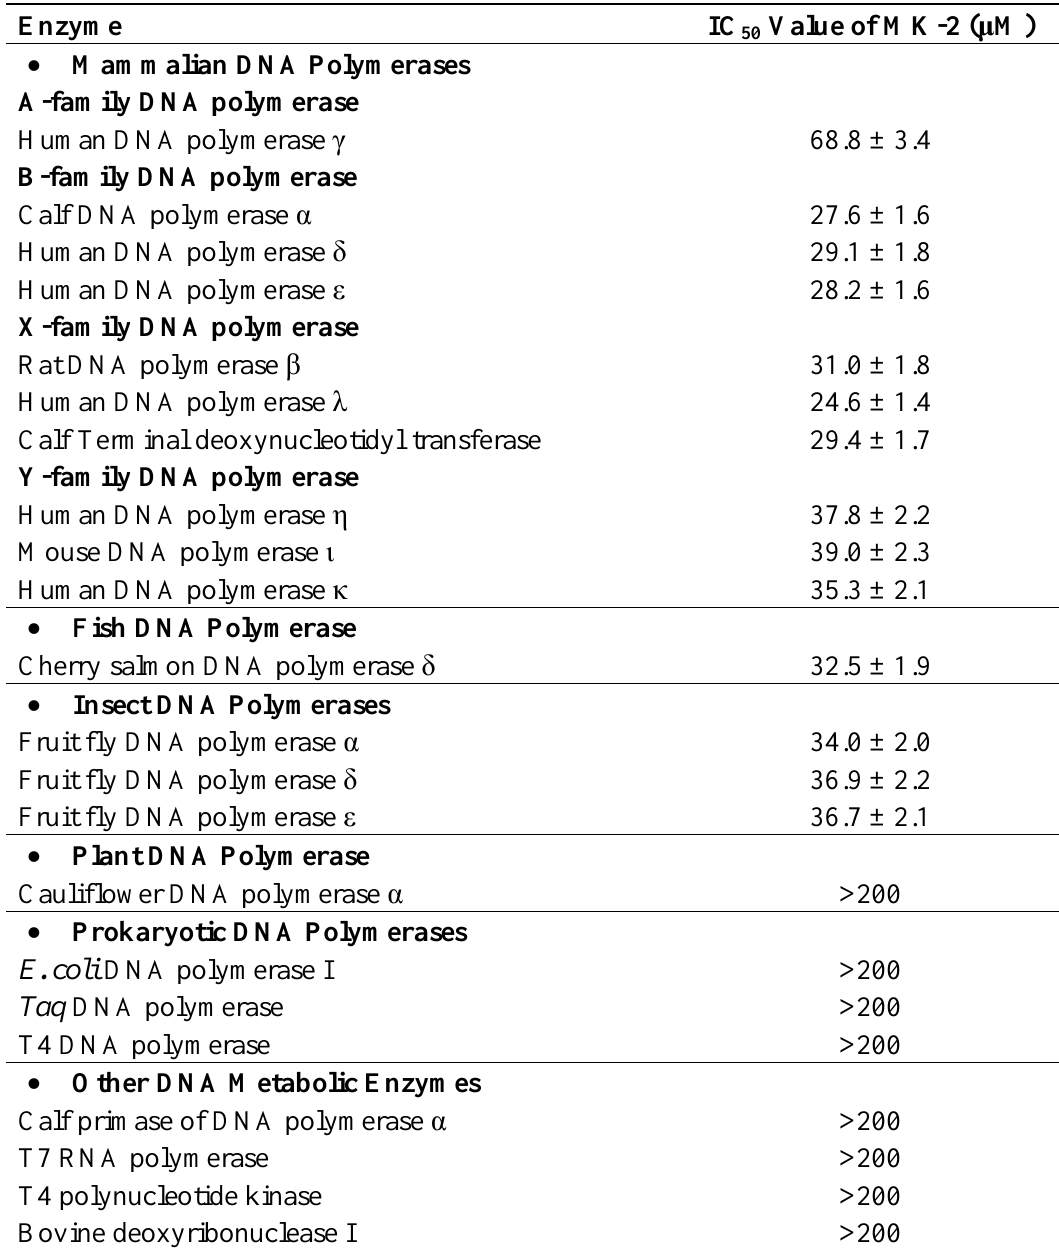
Table 1. IC values of MK-2 against the activities of various DNA polymerases and other 50 DNA metabolic